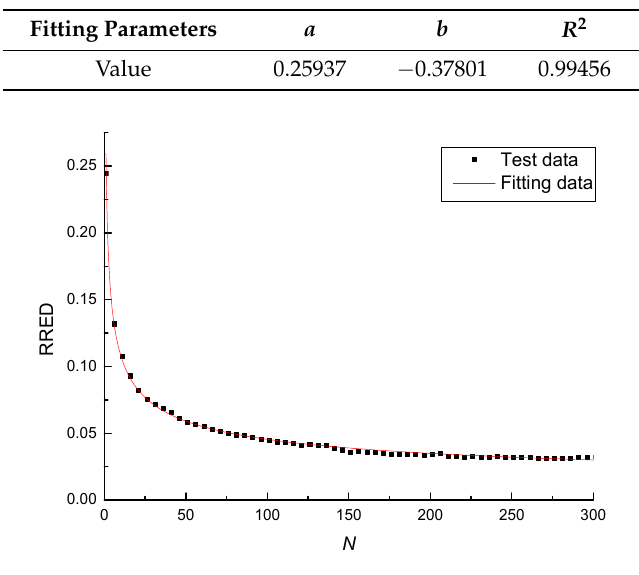
Table 4. Fitting results of RRED mathematical model.